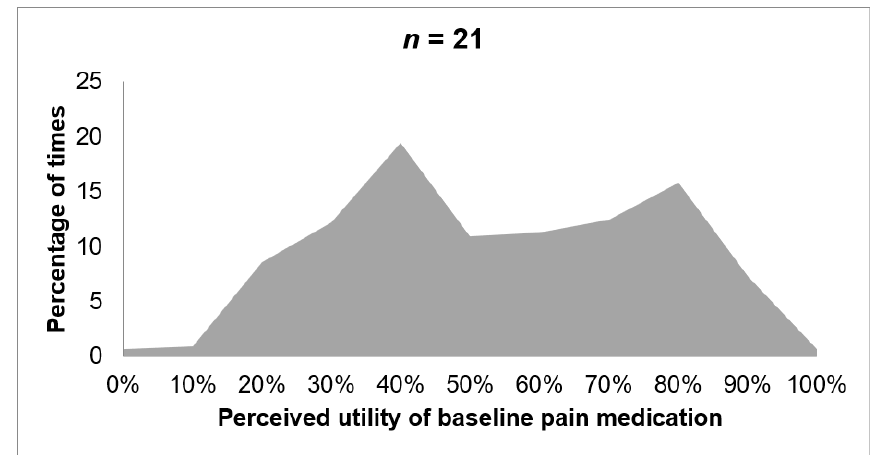
Figure 4. Perceived relief of baseline medication for pain.